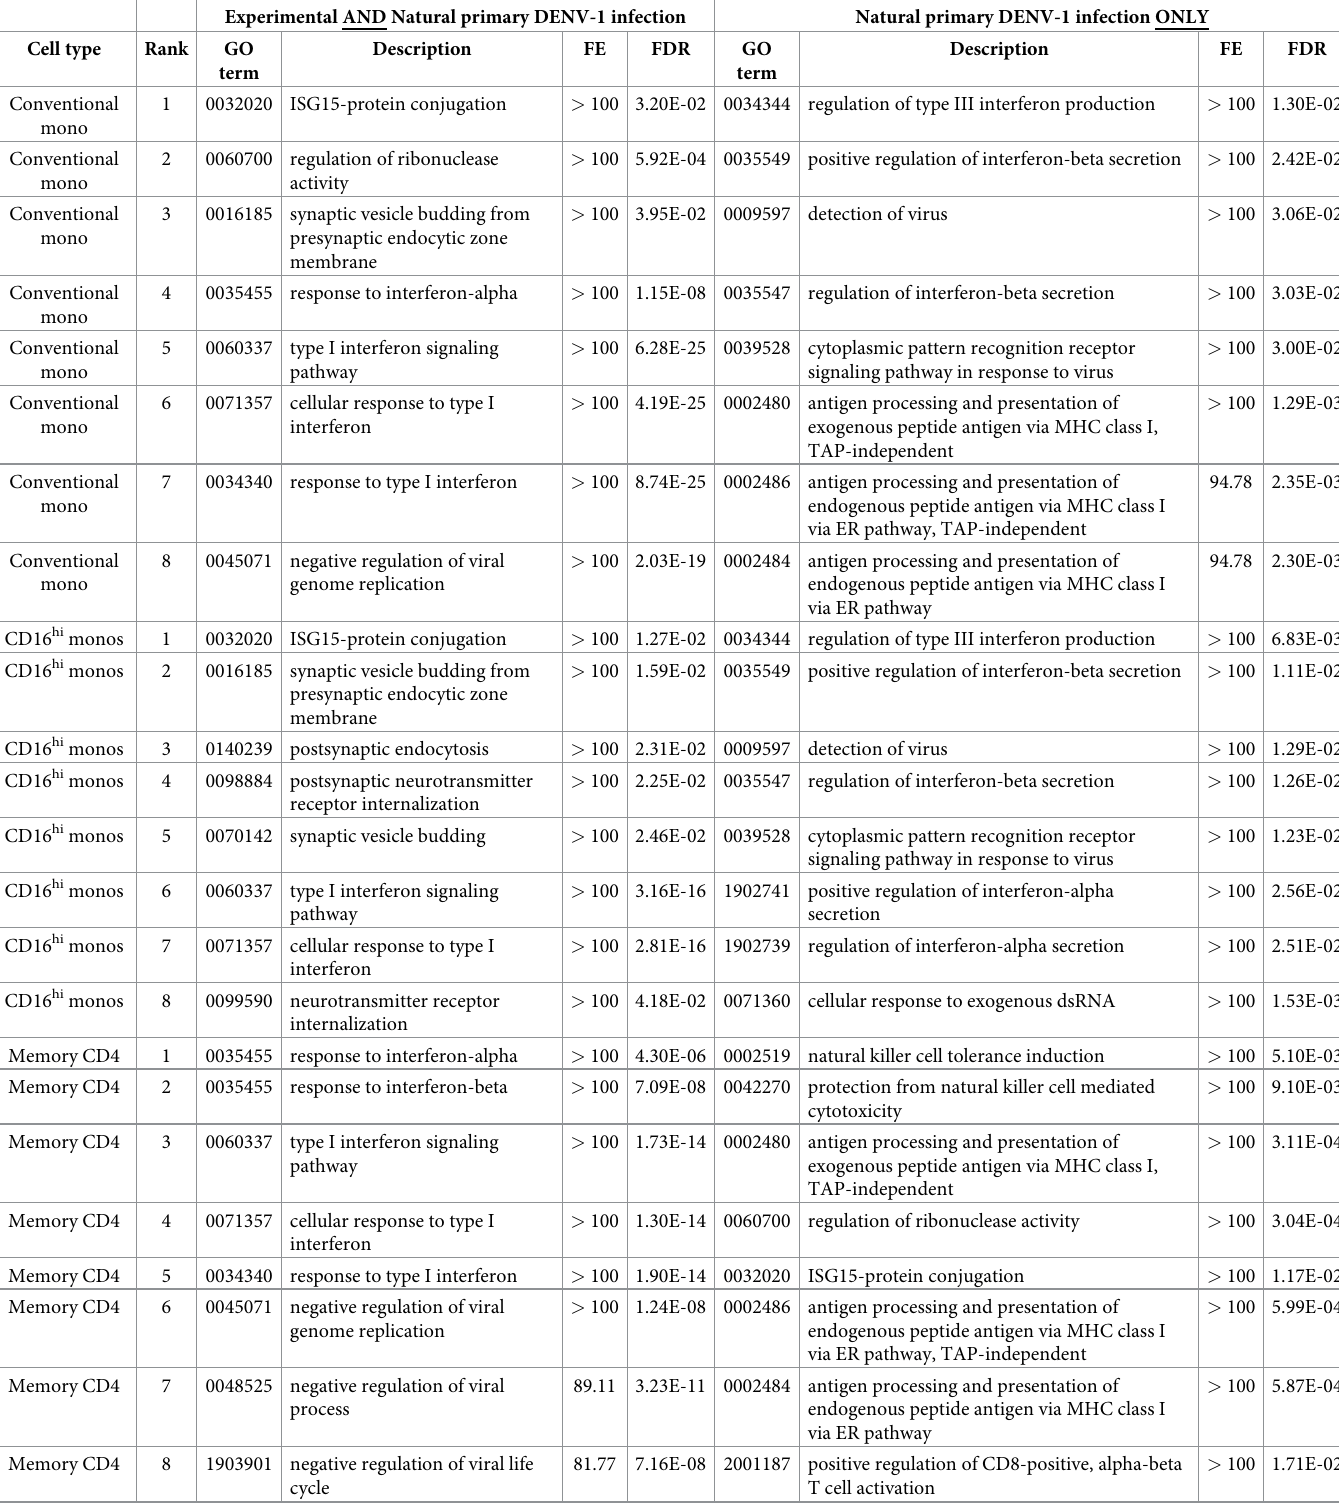
Table 2. Enriched GO terms in overlapping and natural infection only cell